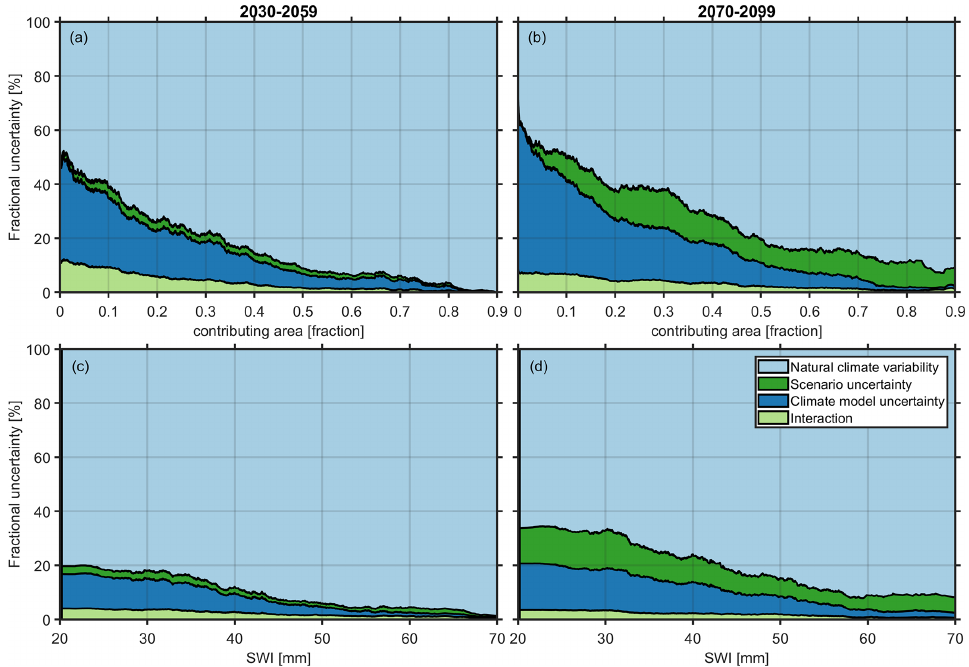
Figure 12. Same as Fig. 11c and d for the exceedance probability of the variables “contributing area” and total area-averaged SWI using criterion 3 (cf. Figs. 8 and